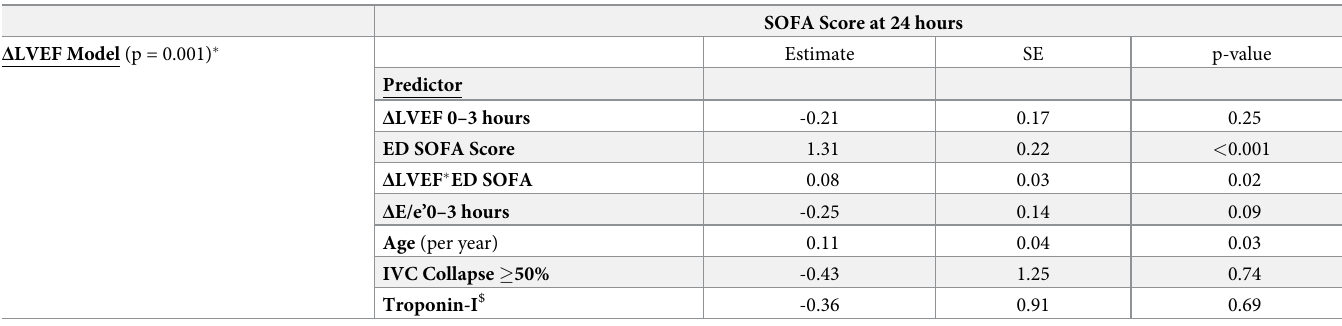
Table 3. Linear model for 24-hour sofa